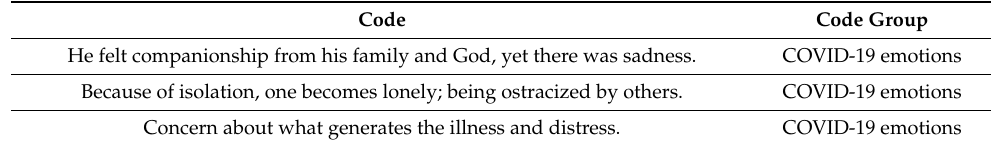
Table 8. Code group: COVID-19 emotions.